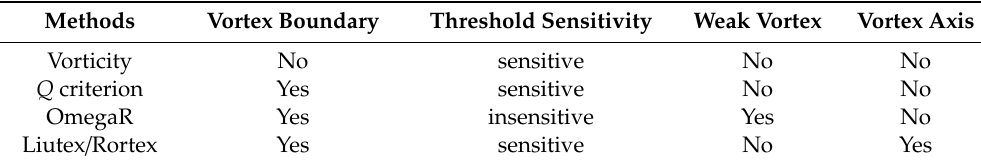
Table 8. Comparison of the di ff erent vortex identification